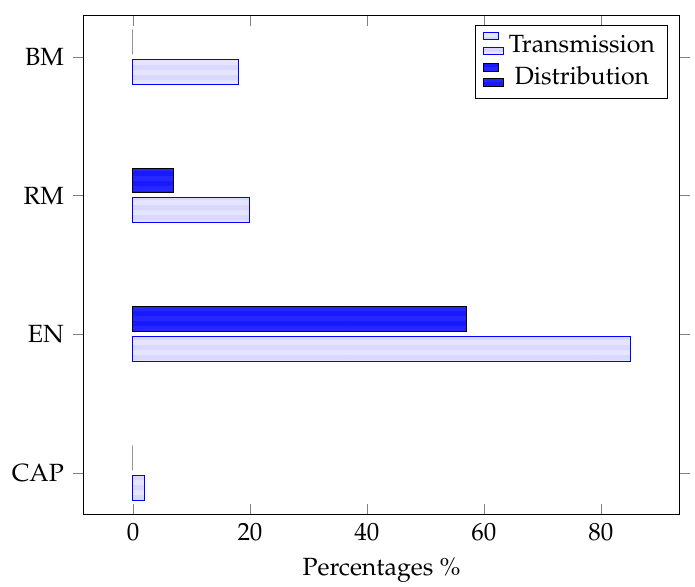
Figure 4. Share of the reviewed literature that considered ESS operation in different